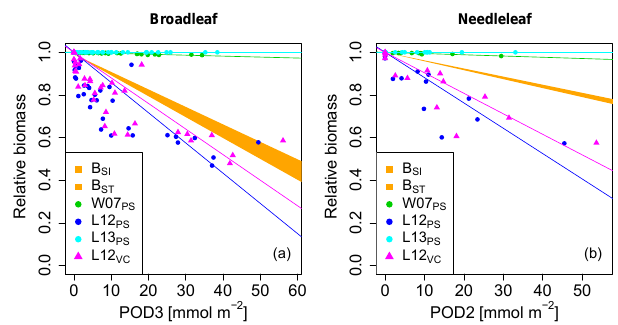
Figure 1. Biomass dose–response relationships for simula- tions based on published injury relationships, separate for (a) broadleaved species and (b) needleleaf species. The dose– response relationships by Büker et al. (2015) ( B SI and B ST ) de- fine the target area (orange). The displayed dose–response relation- ships are simulated by model versions which base injury calcu- lations either on net photosynthesis W07 PS (Wittig et al., 2007), L12 PS (Lombardozzi et al., 2012a) and L13 PS (Lombardozzi et al., 2013) or on V cmax L12 VC (Lombardozzi et al., 2012a) (see Table 1 for more details). See Tables A3 and A4 for slopes, intercepts, R 2 and p values of the displayed regression lines. Injury calculation in the simulations is based on CUOY (see Table 1) and not on POD2 or POD3 (see Sec. 2.5 for more